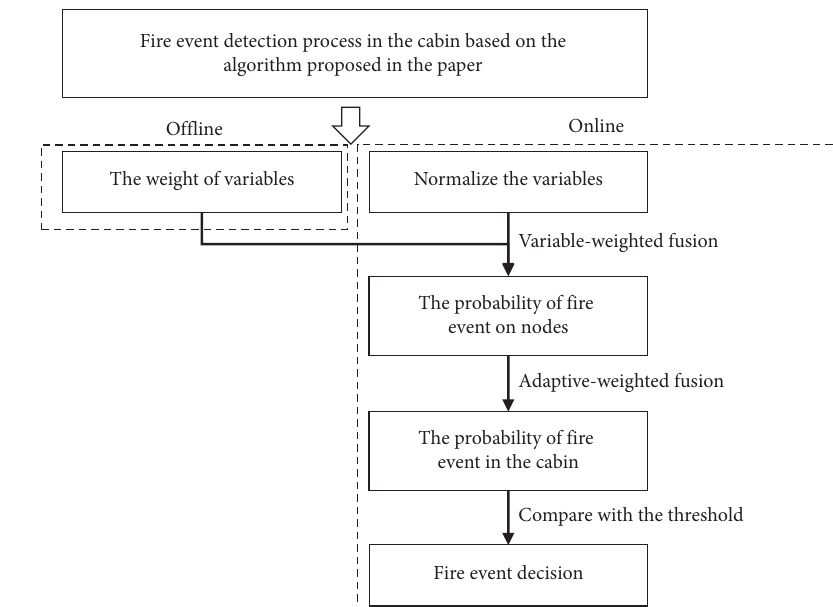
Figure 1: Fire detection flowchart.